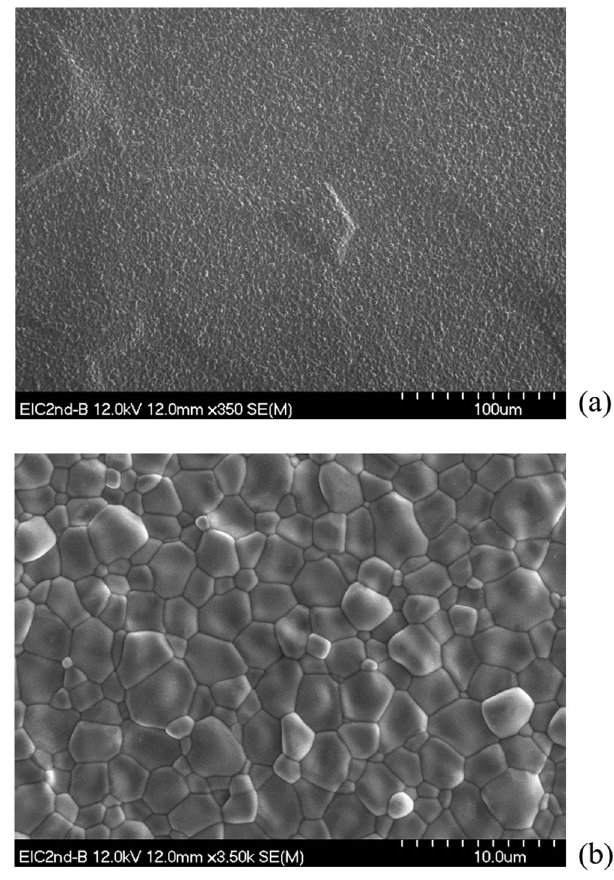
FIG. 9. (a) Low (× 350 ) and (b) High magnification (× 3 . 5 k) SEM images of the Nb 3 Sn film on a Nb witness sample after the second coating.